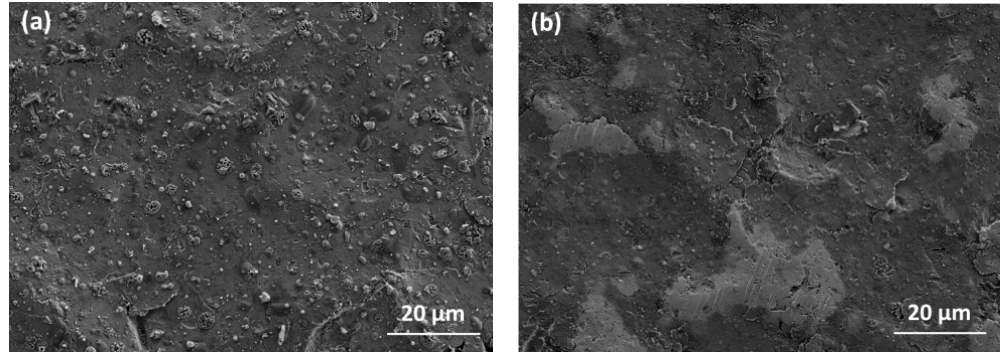
Figure 9. SEM micrographs of the surface of a Zn-SiO x coated austenitic stainless steel surface (secondary precursor concentration of 5 wt.% Zn(NO 3 ) 2 , flow rate of 100 µl/min). ( a ) As-deposited (secondary precursor concentration of 5 wt.% Zn(NO 3 ) 2 , flow rate of 100 µ L/min). ( a ) As-deposited state and ( b ) after 1000 washing cycles. state and ( b ) after 1000 washing